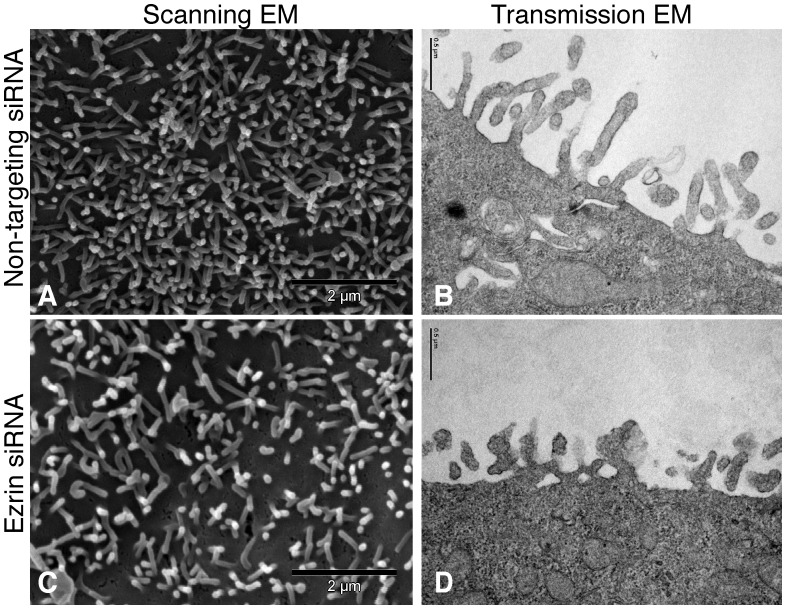
Ezrin knockdown causes shortened, thicker and fewer microvilli.Representative scanning (left two panels) and transmission (right two panels) electron micrographs of the apical surface of MDCK cells stably expressing NHE3’38HA3 after treatment with non-targeting siRNA (top two panels) or siRNA targeted against ezrin (bottom two panels).